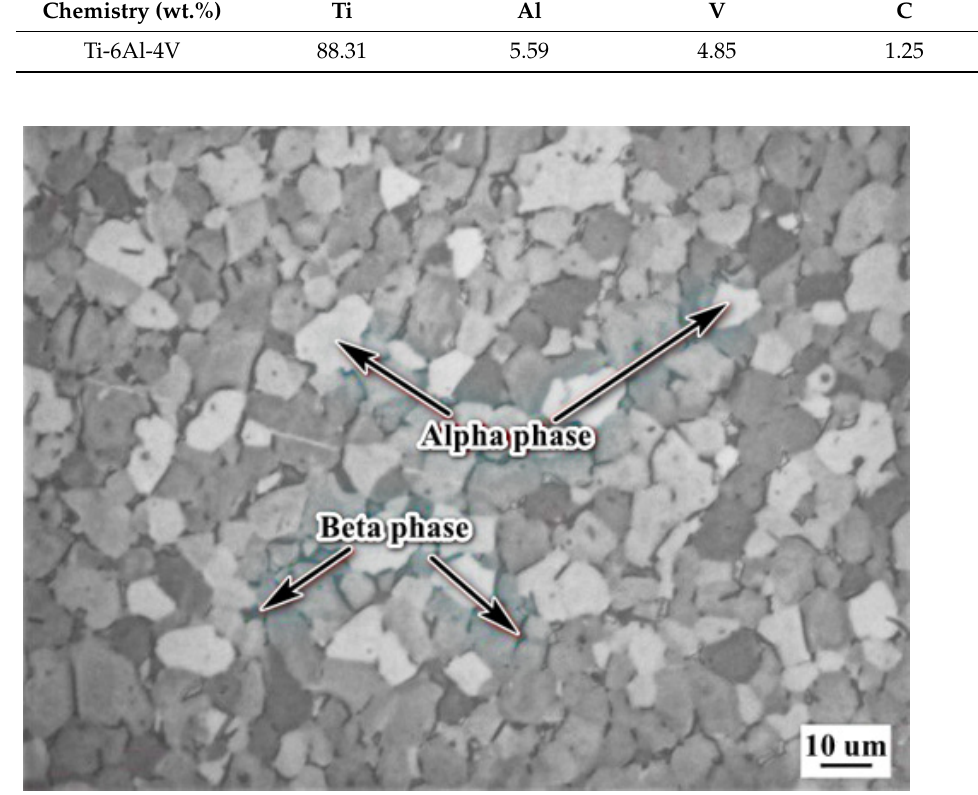
Figure 1. The initial microstructure of received material by OM observation.